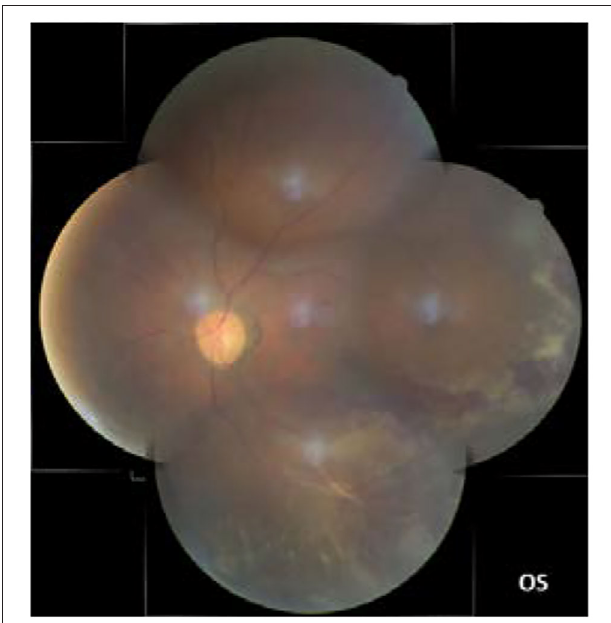
FIGURE 1 | The fundus showed typical necrotizing retinitis, intraretinal hemorrhages, and vasculitis in zones 1–3 (the left eye of patient